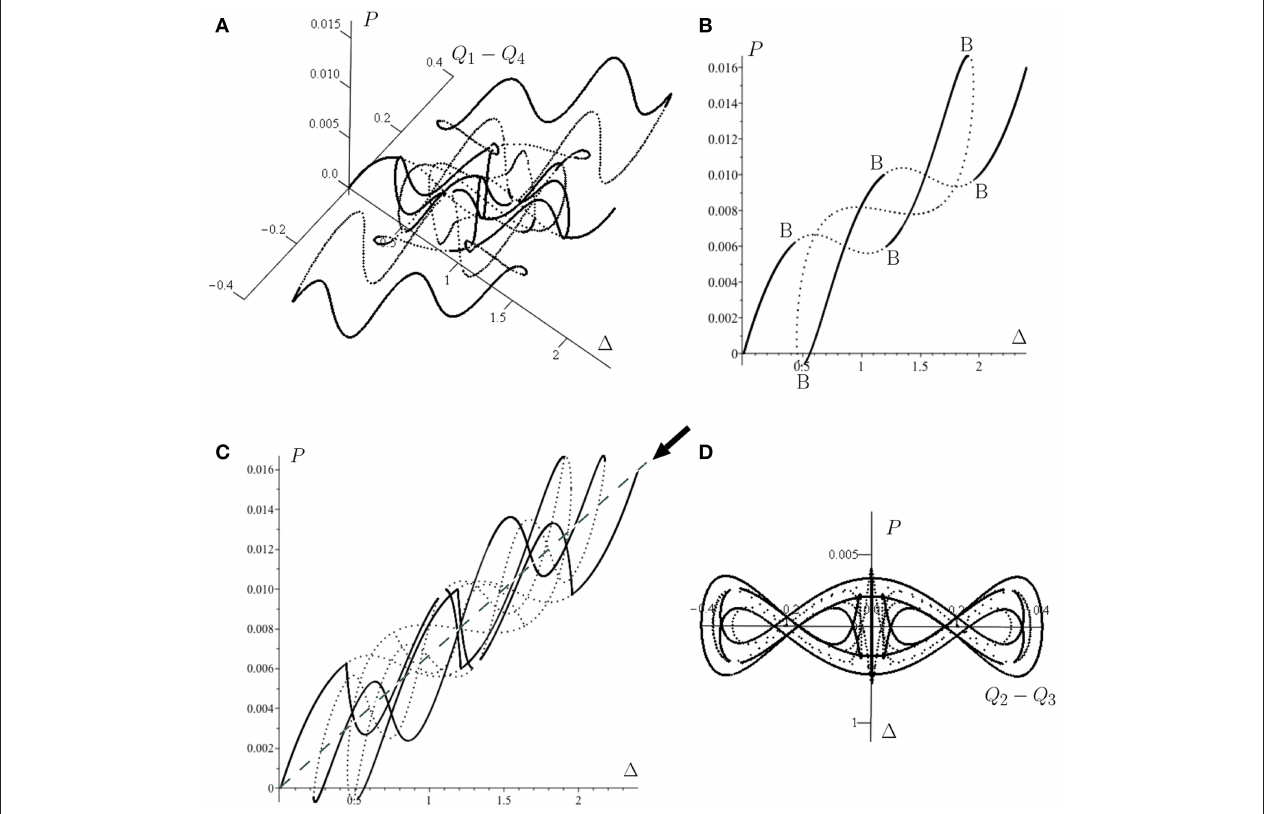
FIGURE 25 | Response of the three-tier system of Figure 24 , for L and the symmetry-breaking variable ( Q 1 on to plane perpendicular to the direction of the arrow in (C) .